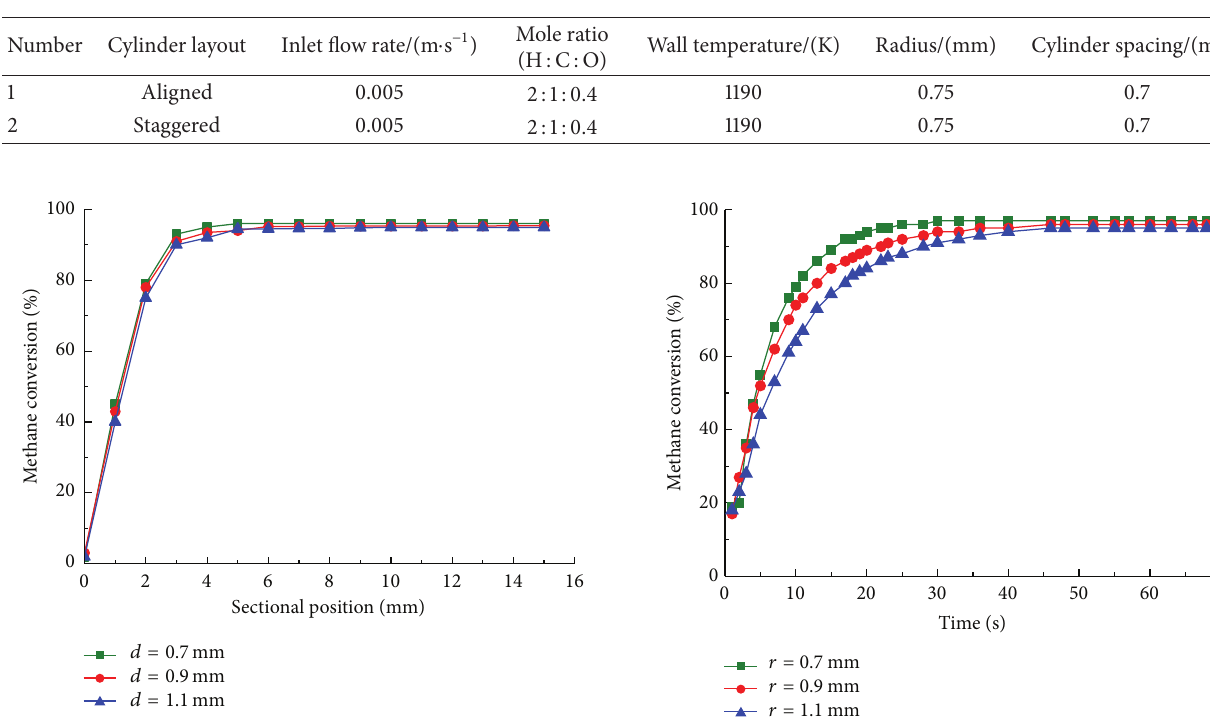
Table 6: Operating parameters with different cylinder layout.